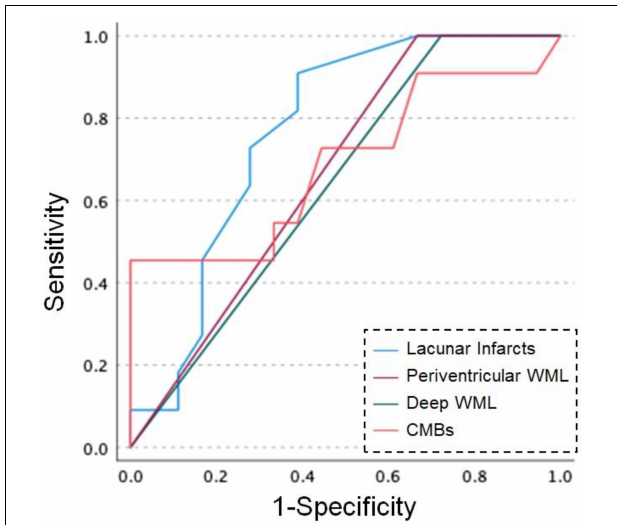
FIGURE 1 | Receiver operating characteristic (ROC) curves for dementia and MRI findings in patients with CADASIL. Blue line: number of lacunar infarcts, purple line: Fazekas scores of periventricular white matter lesion (WML), green line: Fazekas scores of deep WML, orange line: number of cerebral microbleeds